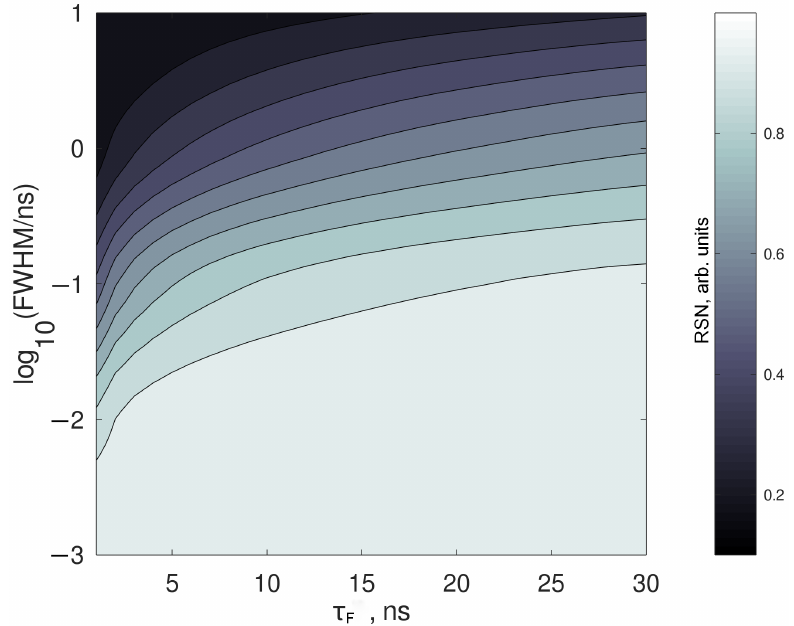
Figure 5. The best RSN achievable in a time-gated Raman system when a 100-times stronger fluorescence signal is overimposed to Raman signal, as a function of the fluorescence decay time and the laser full width half maximum pulse length. The gating time is always about 1.7 × FWHM. Pulse asymmetries do not significantly change the